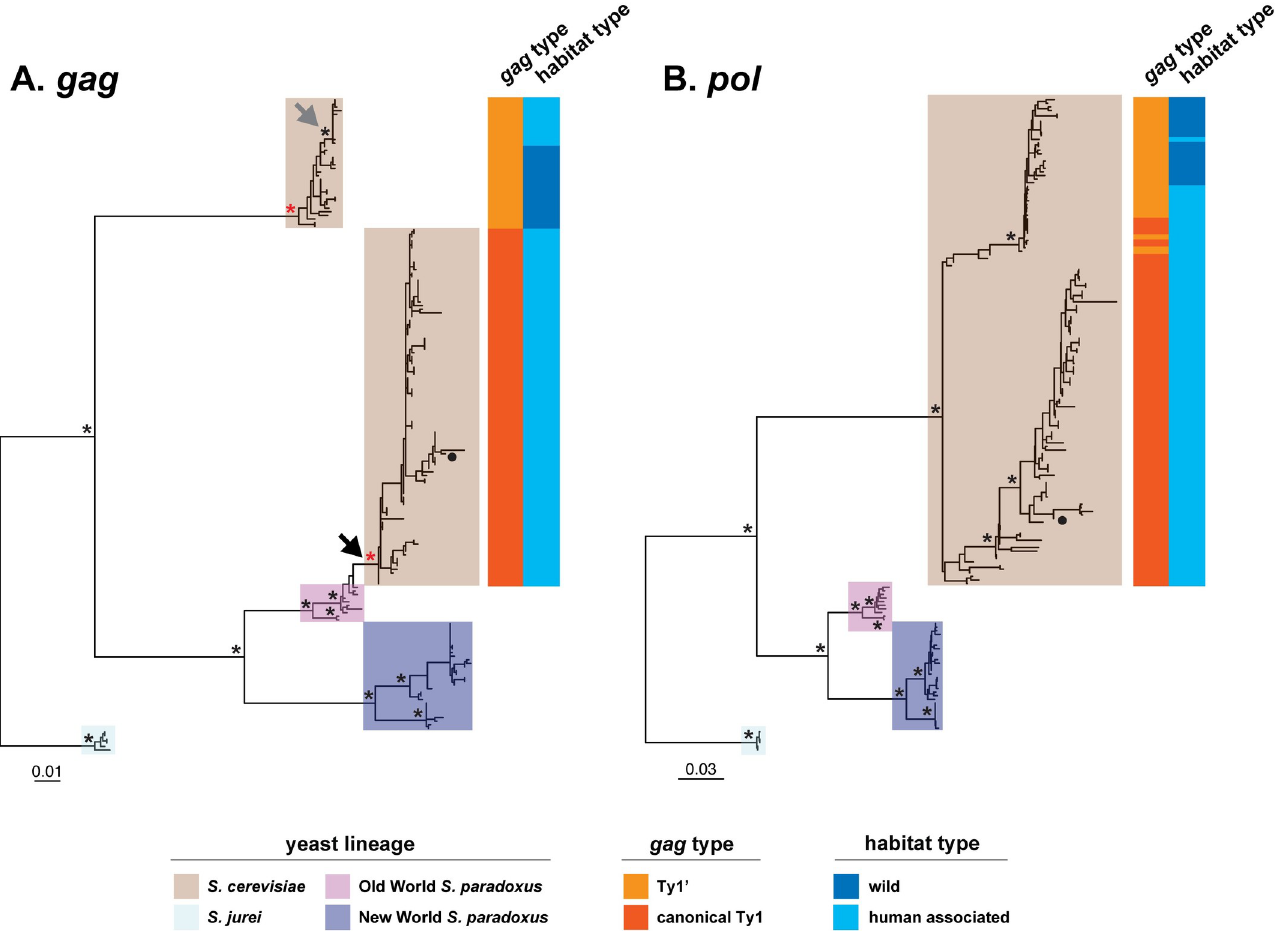
Fig 4. Phylogeny of gag and pol genes from full-length Ty1 elements in S . cerevisiae and S . paradoxus . Maximum likelihood phylogenies of ( A ) gag and ( B ) pol genes from full-length Ty1 elements in complete PacBio assemblies from 15 strains of S . cerevisiae and S . paradoxus , plus two strains of the outgroup species S . jurei . The scale bar for branch lengths is in units of substitutions per site. Asterisks represent key nodes in the phylogeny with bootstrap support > 80%. The filled black circle represents the canonical Ty1-H3 element used in mobility assays. Red asterisks in ( A ) represent nodes for the ancestors of all canonical Ty1 and Ty1’ gag sequences, respectively, whose sequences are reconstructed in Fig 5. The black arrow in ( A ) shows evidence that the canonical Ty1 gag in S . cerevisiae is derived from an Old-World S . paradoxus lineage. The grey arrow in ( A ) shows evidence that elements with Ty1’ gag in human-associated S . cerevisiae have a monophyletic origin derived from a wild S . cerevisiae